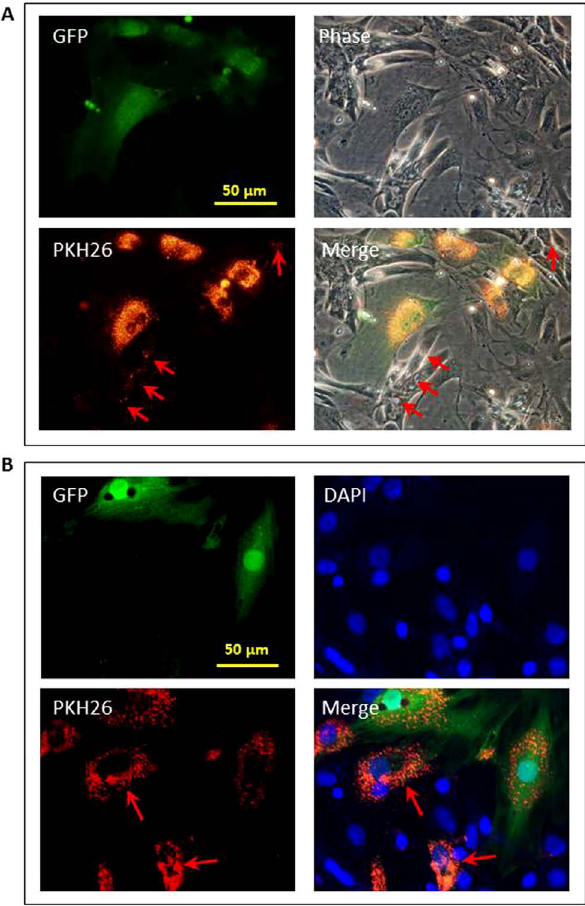
Figure 5. Transfer of bioactive molecules from MSC to CM. MSC pre-labeled with PKH26 were co-cultured with CM for 4 days. PKH26 was visible in GFP positive MSC and in some CM (red arrows). Panel A: co-culture of MSC and CM before fixation. Panel B: co-culture of MSC and CM after fixation and counterstained with DAPI.